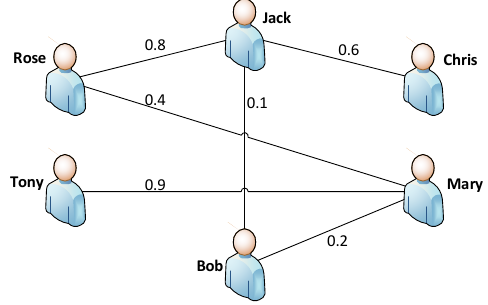
Fig. 1 A social network with social influences on